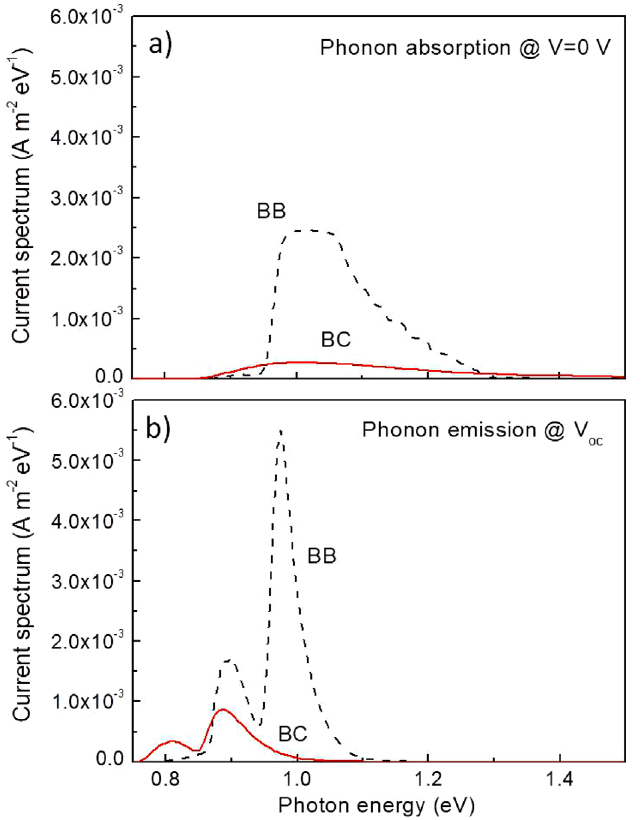
Fig. 3. Current density versus the photon energy generated in each structure B – B and B – C by (a) photon absorption and (b) photon emission.